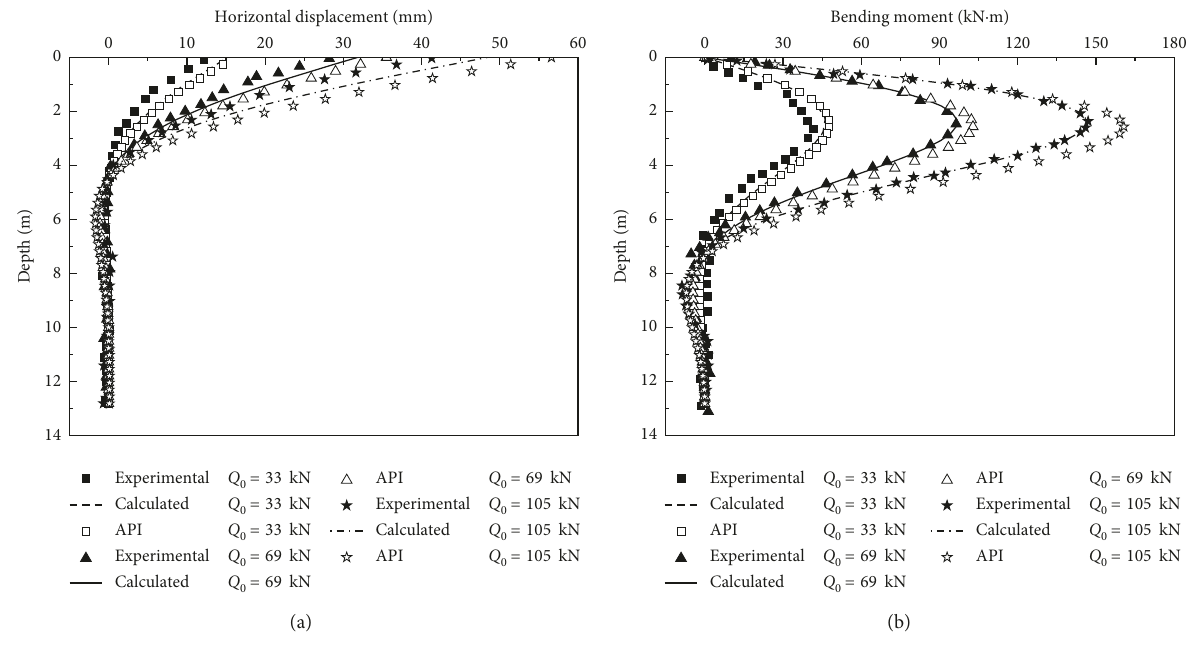
Figure 6: The comparison of the horizontal displacement (a) and bending moment